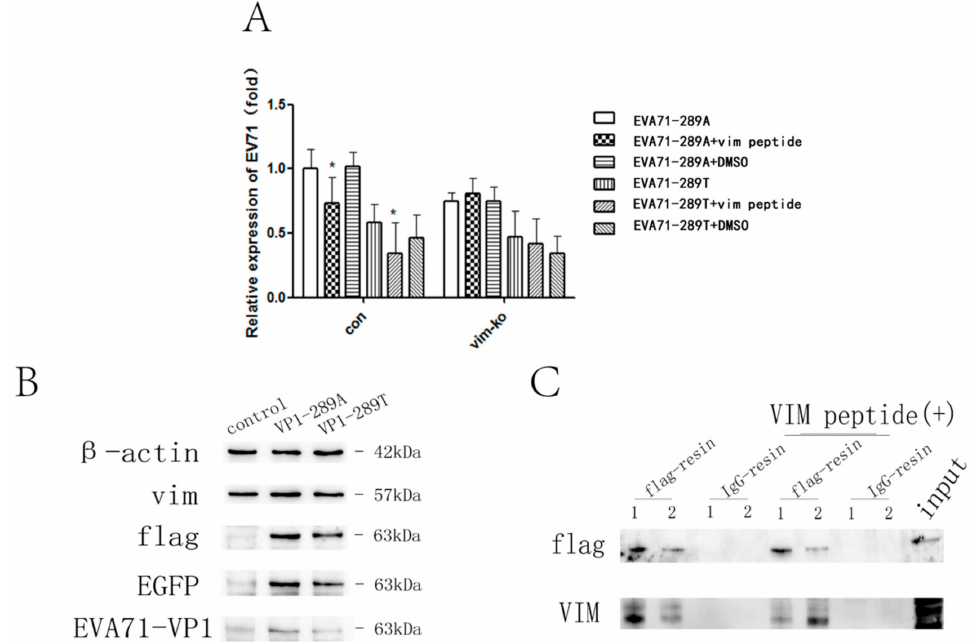
Figure 3. Assessment of the interaction among EV-A71-289A, EV-A71-289T, and VIM. Viral attachment to control human brain microvascular endothelial cells (HBMECs) and VIM-KO HBMECs was detected via quantitative RT-qPCR analysis after infection with EV-A71-289A and EV-A71-289T at 4 ◦ C for 1 h after viral incubation with VIM peptide or DMSO (1%) ( A ). Cell lysates were harvested for western blotting ( B ) and then incubated overnight at 4 ◦ C with immobilized anti-flag antibody or normal IgG after 293T cells were transfected with expression vectors expressing VP1(289A)-flag and VP1(289T)-flag. Figure C shows a western blot of the following precipitated protein samples using anti-Flag and anti-VIM antibodies: VP1(289A)-flag (1) and VP1(289T)-flag (2) incubated with anti-flag-resin;